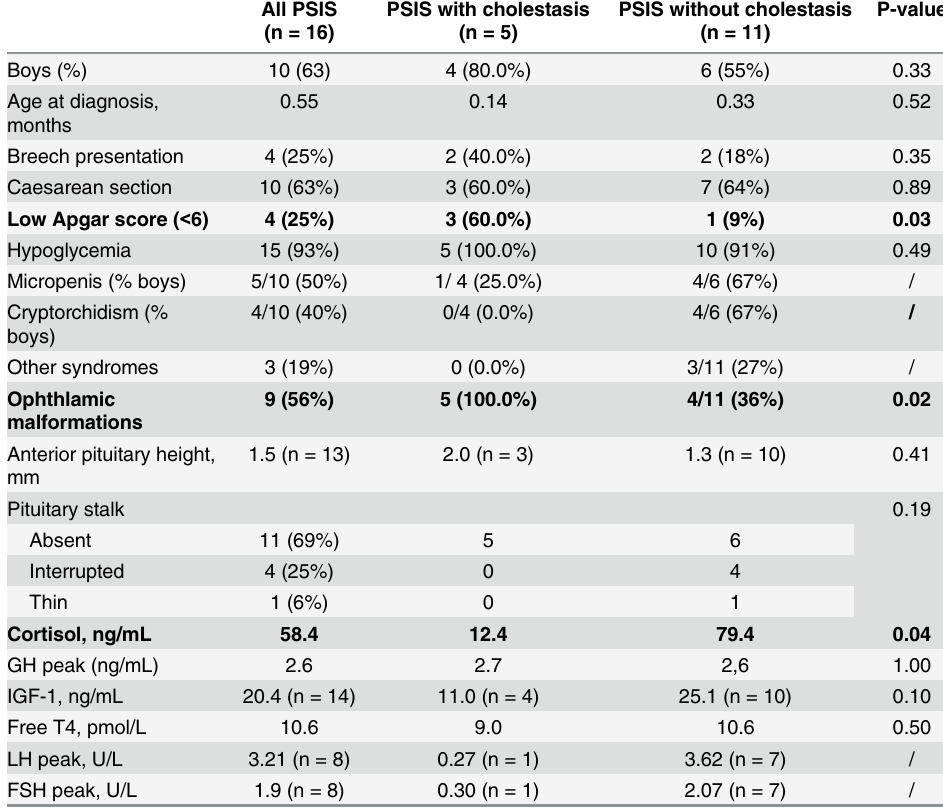
Table 3. Comparison between PSIS patients with or without